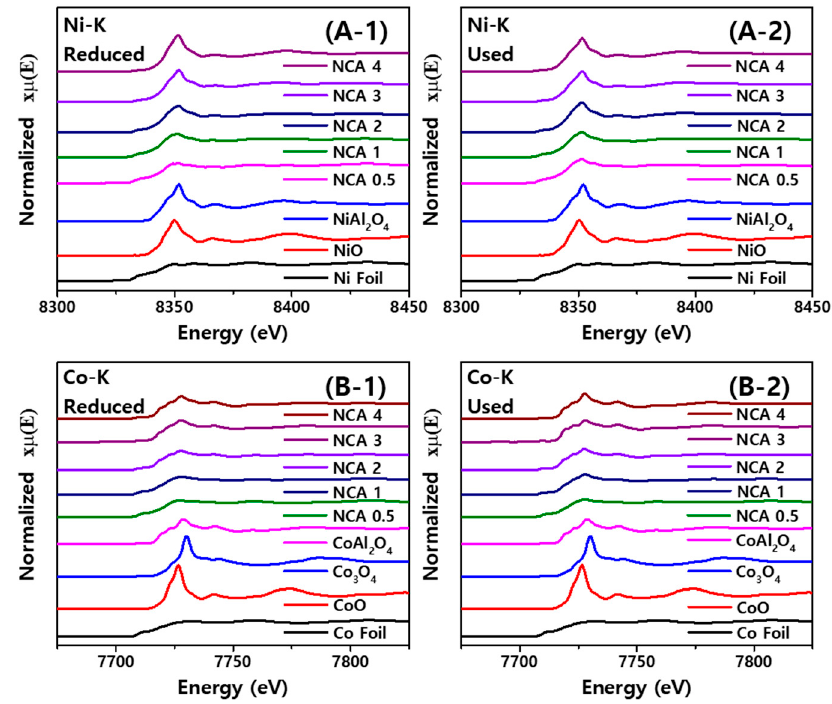
Figure 4. X-ray absorption near-edge structure (XANES) spectra of ( A ) Ni K-edge and ( B ) Co K-edge on the ( 1 ) reduced, ( 2 ) used NCA catalysts with reference materials.